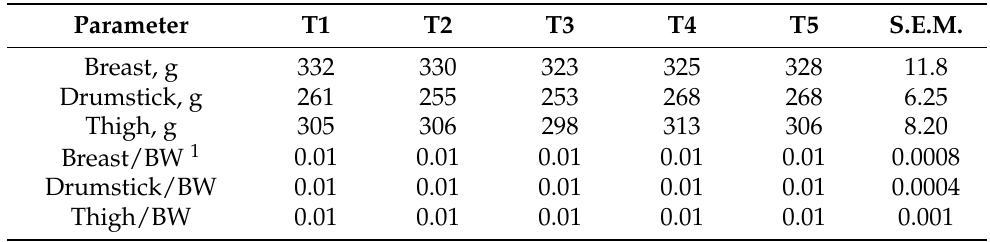
Table 4. Predicted least square means of cut yield of broiler chickens at 42 days of age fed different levels of Black Soldier Fly larvae (BSFL).